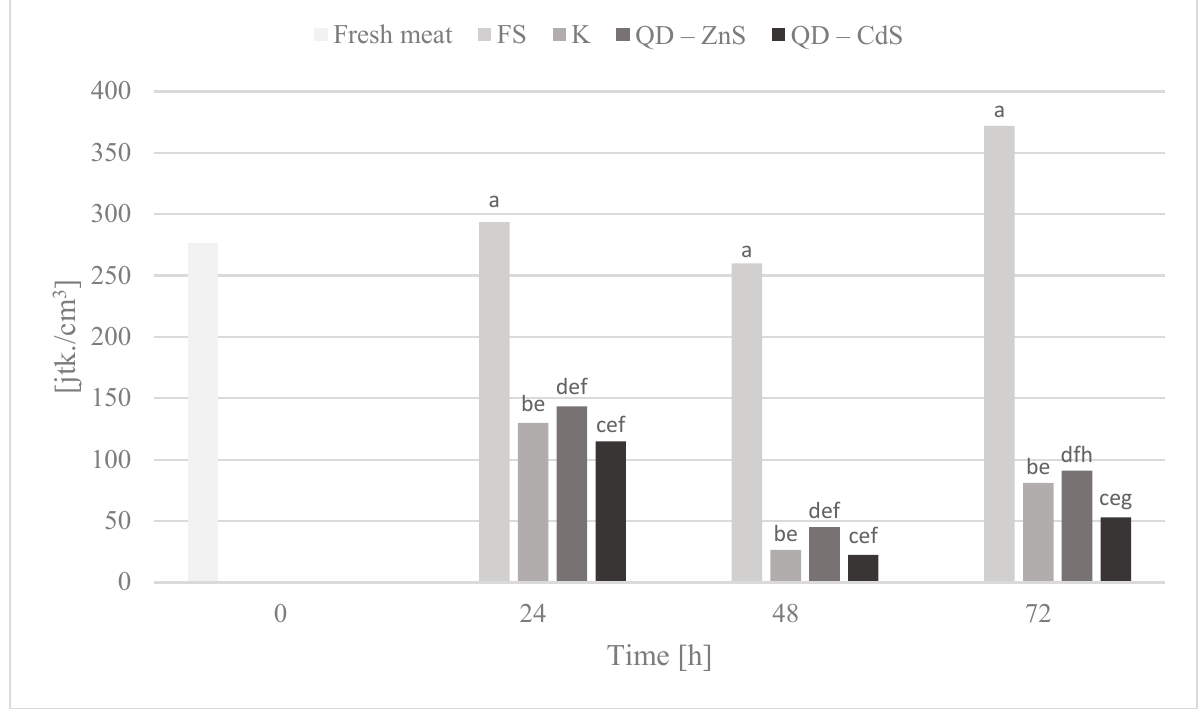
Figure 10. Coagulase ‐ positive Staphylococcus count in poultry meat stored under different films at about 4 °C. The parameters in the columns denoted with the same letters (a, b, c, etc.) do not differ statistically at the confidence level of p < 0.05.